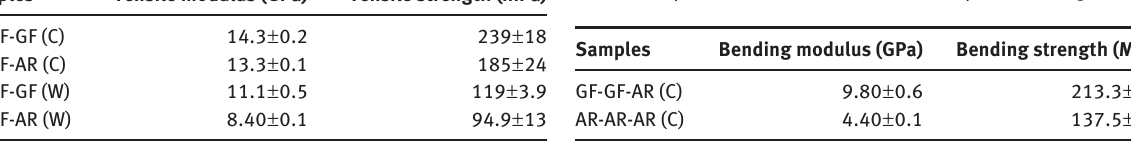
Table 3 Experimental results from the three-point bending